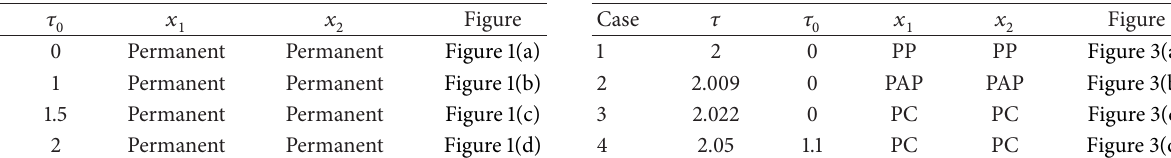
Table 4: Simulations of Model